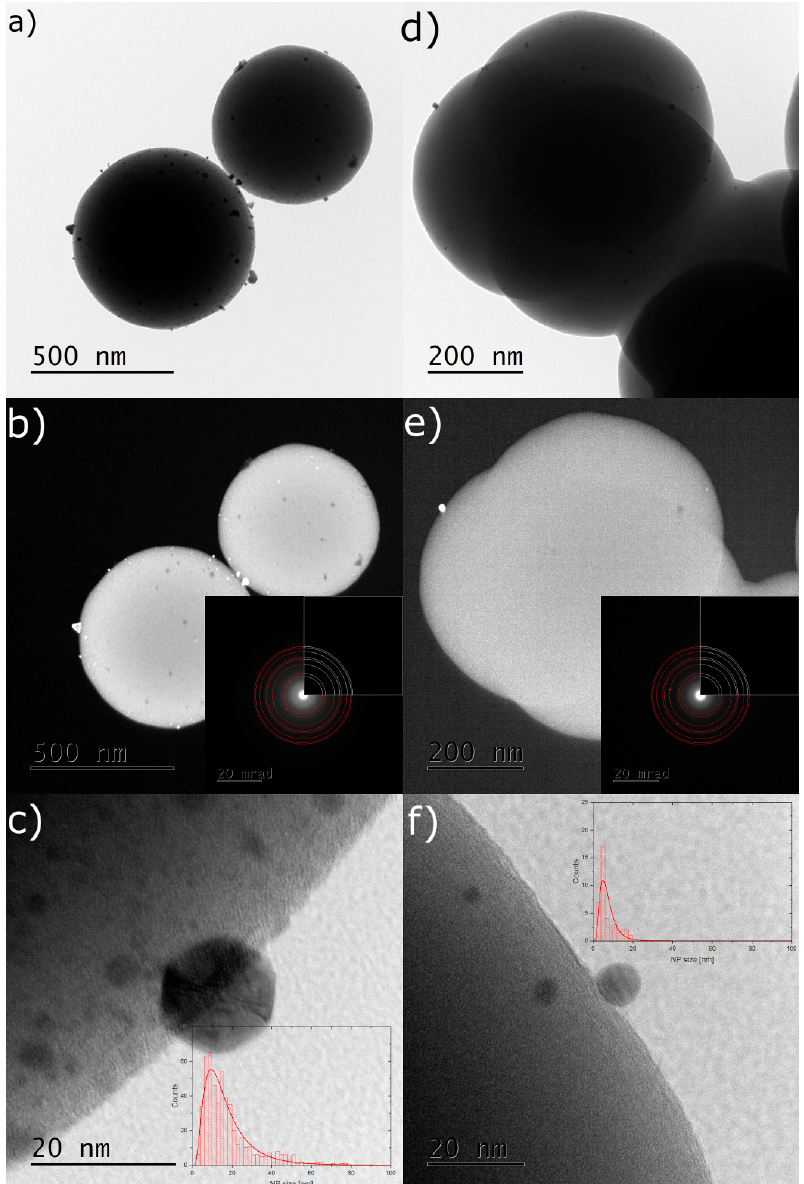
Figure 4. Representative TEM images of the (1.1% Pd; 0.4% Au)/SiO 2 ( a – c ) and 0.1% Au/SiO 2 ( d – f ) catalysts. ( a , d ) nanoparticles on the surface of the SiO 2 particles in the bright field image, ( b , e ) dark field image with an inset of the recorded selected area electron diffraction patterns overlaid by the theoretical diffraction rings for Au, ( c , f ) High-resolution TEM image of the nanoparticles on the SiO 2 surface with an inset showing nanoparticle size distribution.